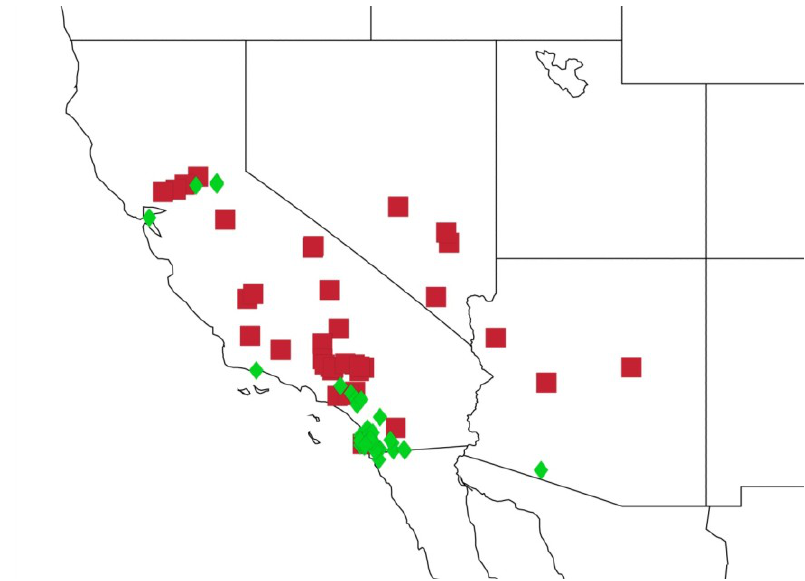
Figure 46. Distribution of Clidophleps vagans (red squares) and C. blaisdelli (green